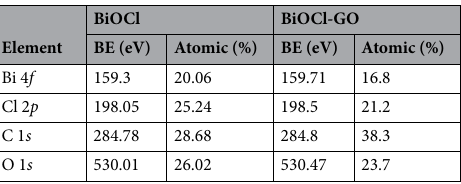
Table 1. Elemental composition of BiOCl and BiOCl-GO (XPS analysis).